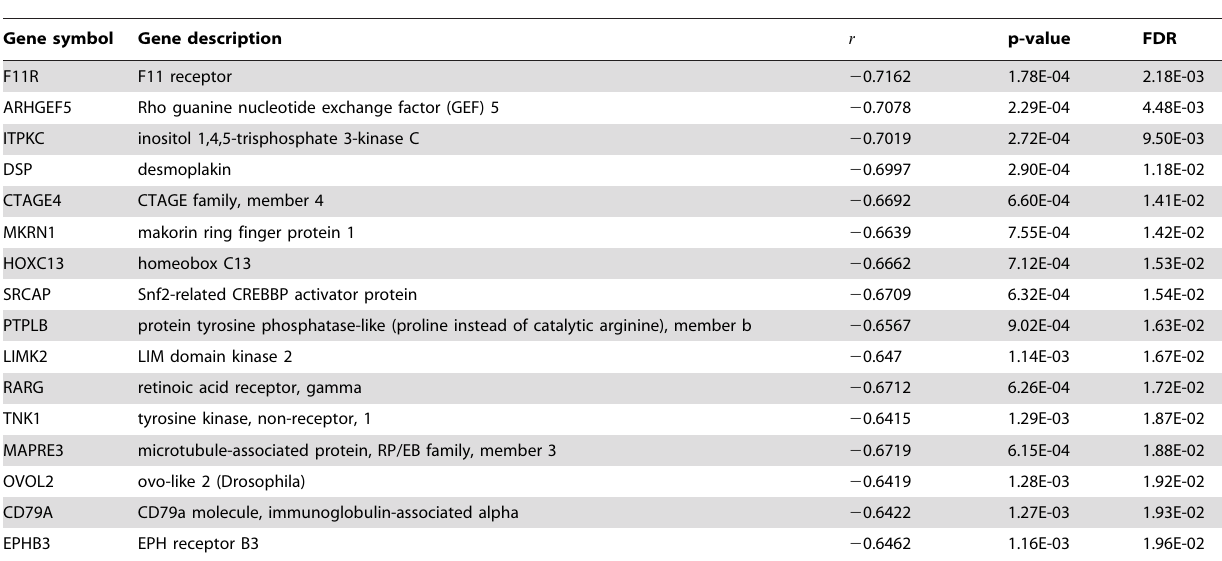
Table 3. Genes that best predict the size of the colony in terms of negative logistic relationship ( FDR v 0 : 02 ).